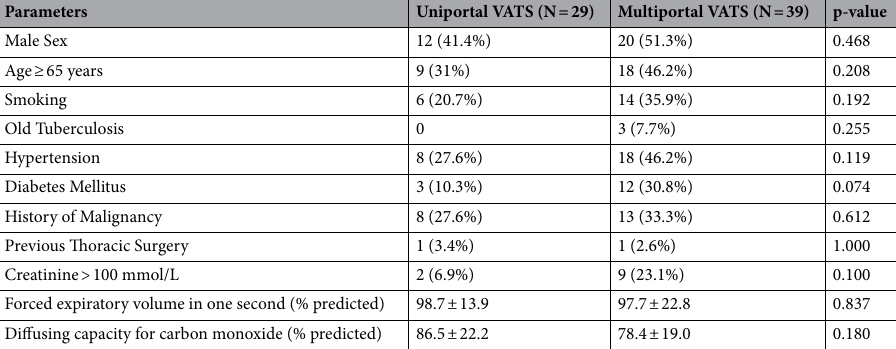
Table 1. Preoperative parameters comparing Uniportal VATS versus Multiportal VATS.